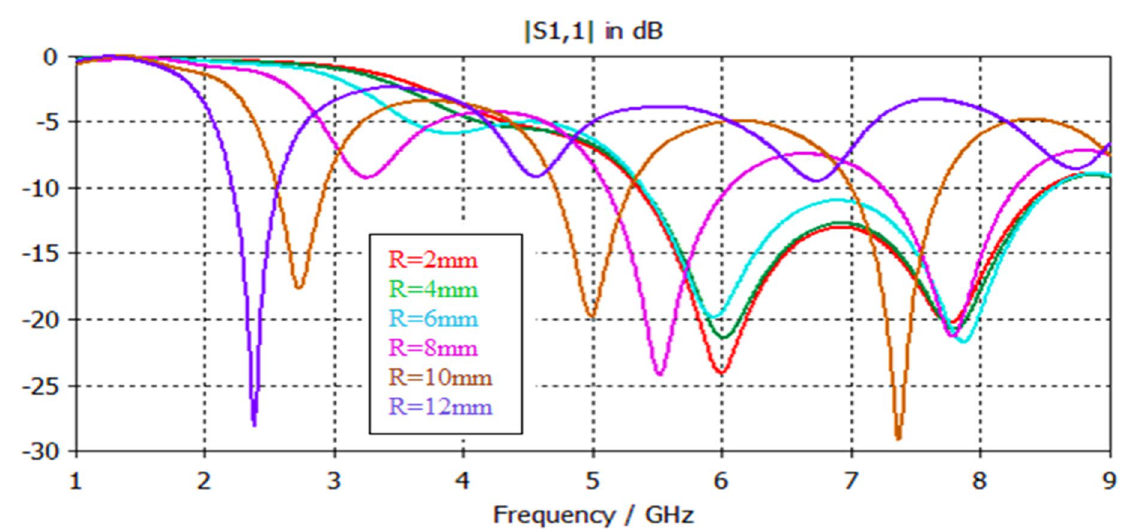
Figure 22. S11 responses based on Antenna4 patch radius variations using a feedline length of 17 mm.